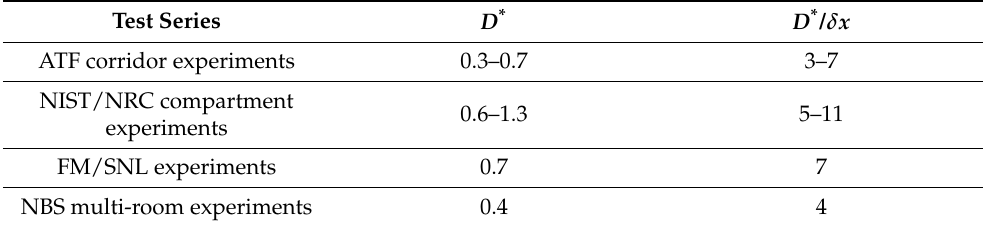
Table 8. Relevant FDS validation guide [34] test